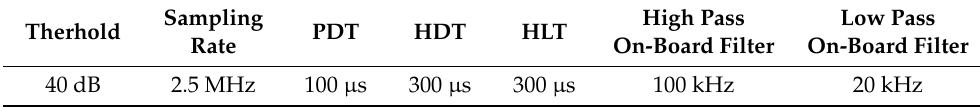
Table 5. Main parameters of the DIC full-field strain monitoring system.